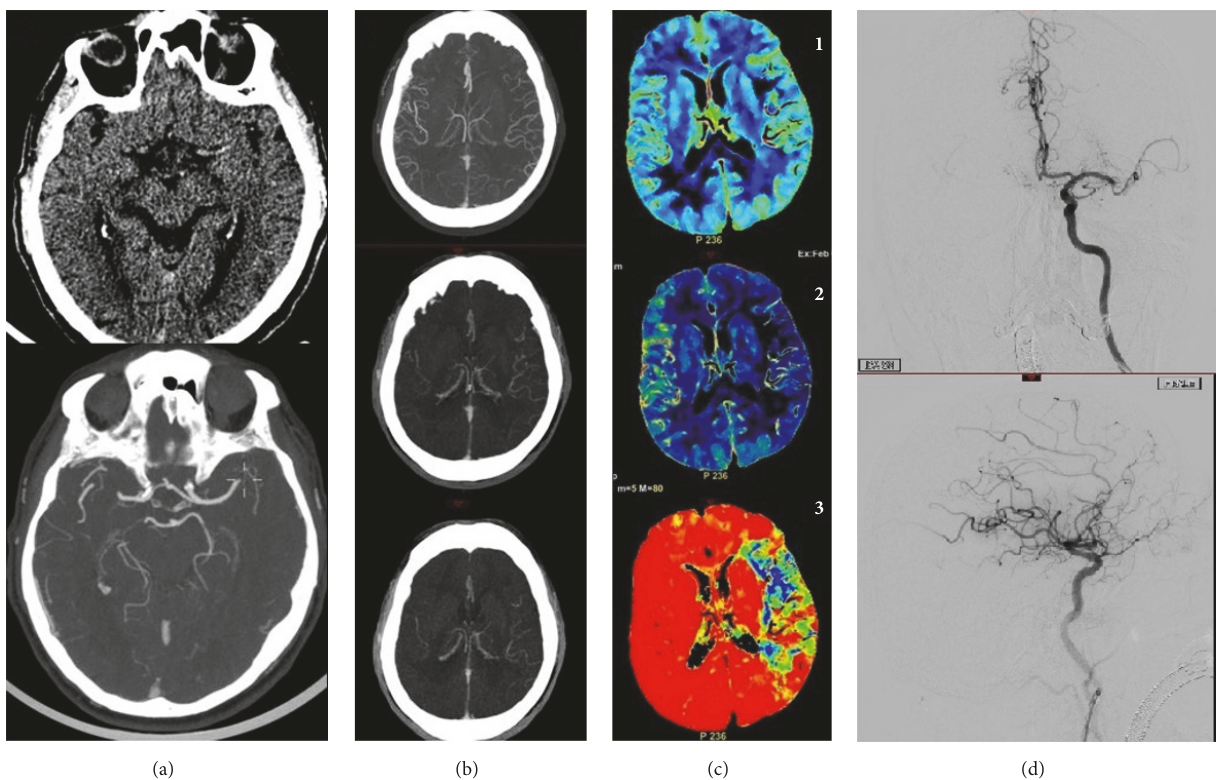
Figure 1: 82-year-old patient, smoker, presenting at 2 hours from symptoms onset with an NIHSS score of 20. (a) CT shows left hyperdense MCA, CTA absence of flow in the same MCA region. (b) Multiphase CTA shows good collaterals in the arterial phase and two venous phases of acquisition. (c) CTP shows mismatch between the large area on MTT (3) and the small infarct core on CBV (1). (d) Angiography shows an occluded MCA with perfect recanalization (TICI